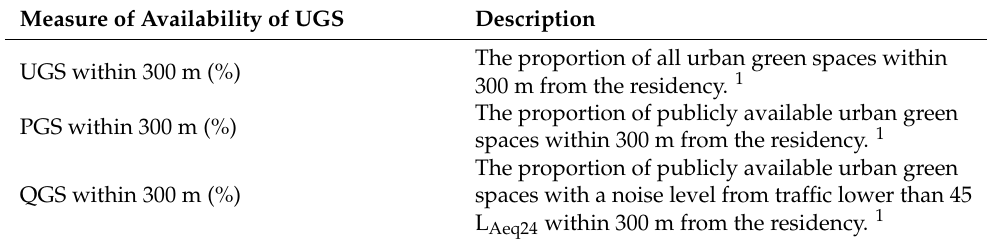
Table 2. Measures of urban green spaces included in the